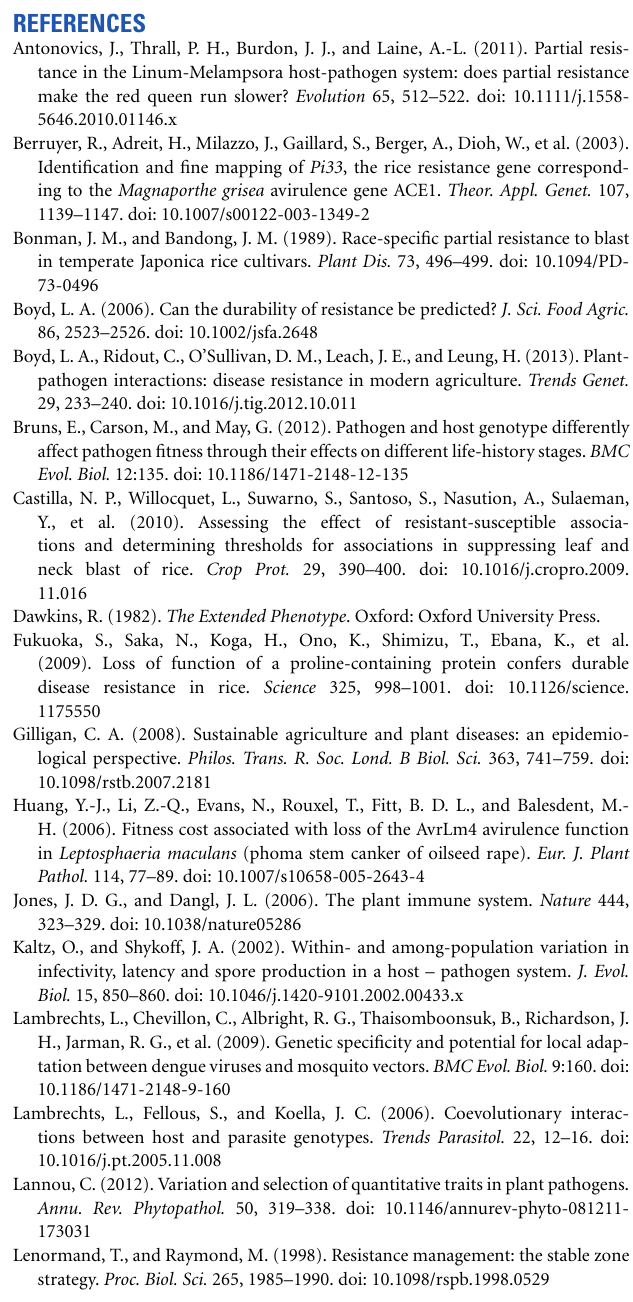
Table S1 | List of the fungal strain used in this study. Table S2 | Statistical analyses. Table S3 | Correlation